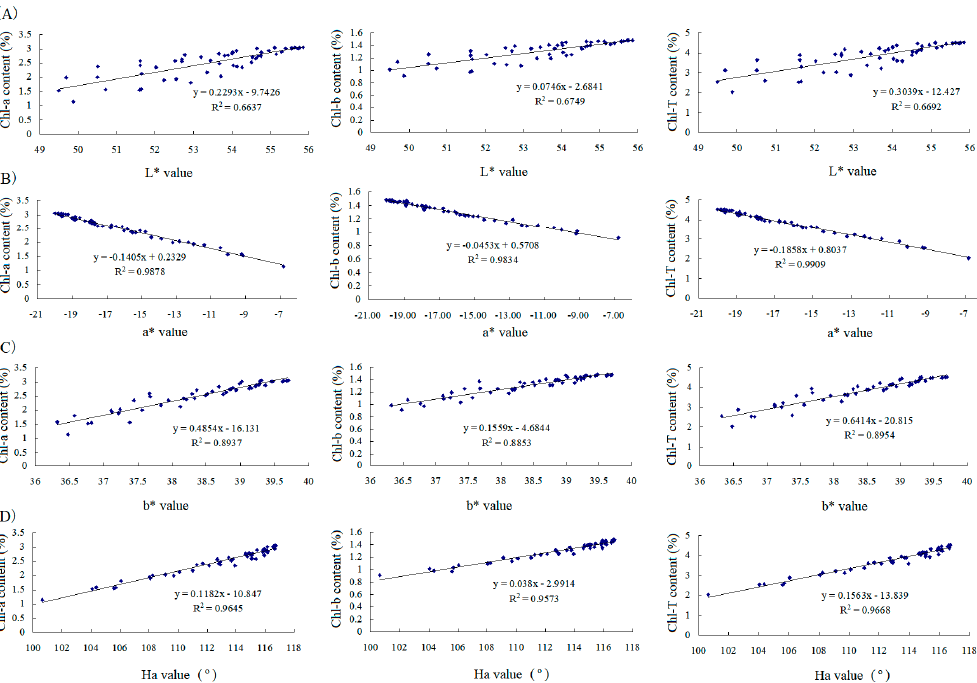
Figure 2. Regression analysis between the L*, a*, b* or H a and chlorophyll a (Chl − a), chlorophyll b (Chl − b), and total chlorophylls (Chl − T). ( A ): L* with Chl-a, Chl-b, and Chl-T; ( B ): a* with Chl-a, Chl-b, and Chl-T; ( C ): b* with Chl-a, Chl-b, and Chl-T; ( D ): H a with Chl-a, Chl-b, and Chl-T.